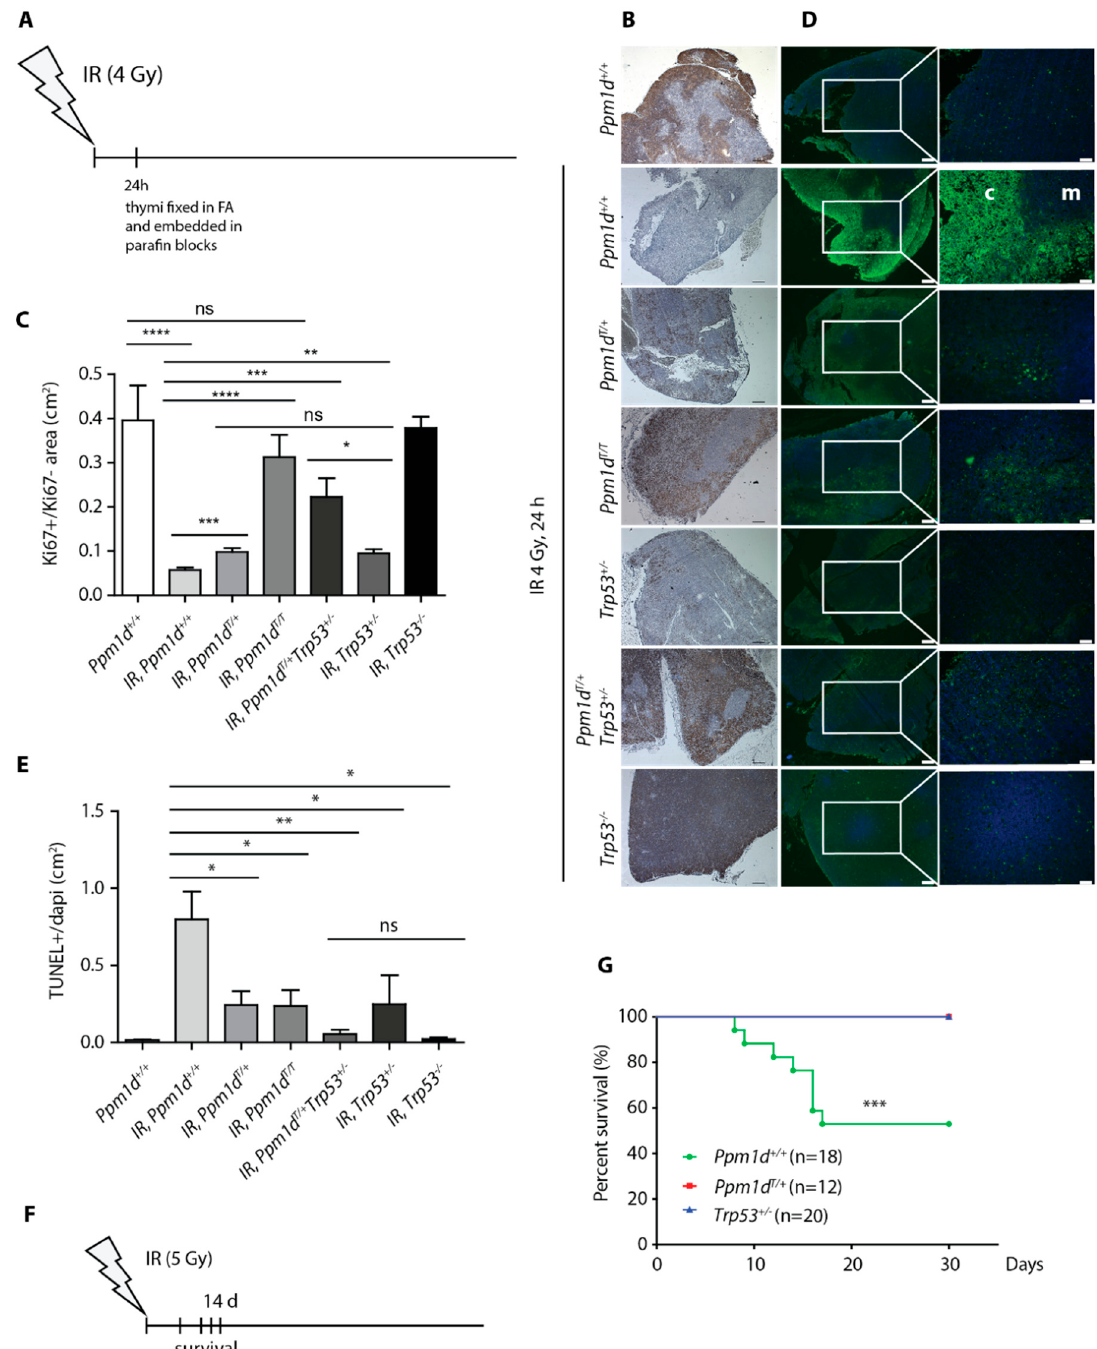
Figure 2. Truncated PPM1D prevents apoptosis and promotes proliferation after genotoxic stress. A scheme of the experimental setup of B–E. Thymi were collected from mice sacrificed 24 h after exposure to mock or to IR (4 Gy) and analyzed by immunohistochemistry ( A ). Histology sections of thymi from mice of indicated genotypes exposed to mock or to IR (4 Gy) were probed with antibody against Ki-67 (proliferation marker). Representative images are shown. Magnification 5×, bars indicate 200 μ m ( B ). Quantification of Ki-67 signal from B. At least 3 sections from 3 mice per genotype were quantified. Error bars indicate SD. Statistical significance was evaluated by two-tailed t-test ( C ). Histology sections of thymi from mice of indicated genotypes exposed to mock or to IR were subjected to TUNEL assay (apoptosis marker). Note high TUNEL+ signal in cortex (c) but not in medulla (m) of the Ppm1d +/+ Trp53 +/+ mice. Representative images are shown. Magnification 5× and 20×, bars indicate 200 μ m and 50 μ m, respectively ( D ). Quantification of TUNEL+ signal from D. At least 3 sections from 3 mice per genotype were quantified. Error bars indicate SD. Statistical significance was evaluated by